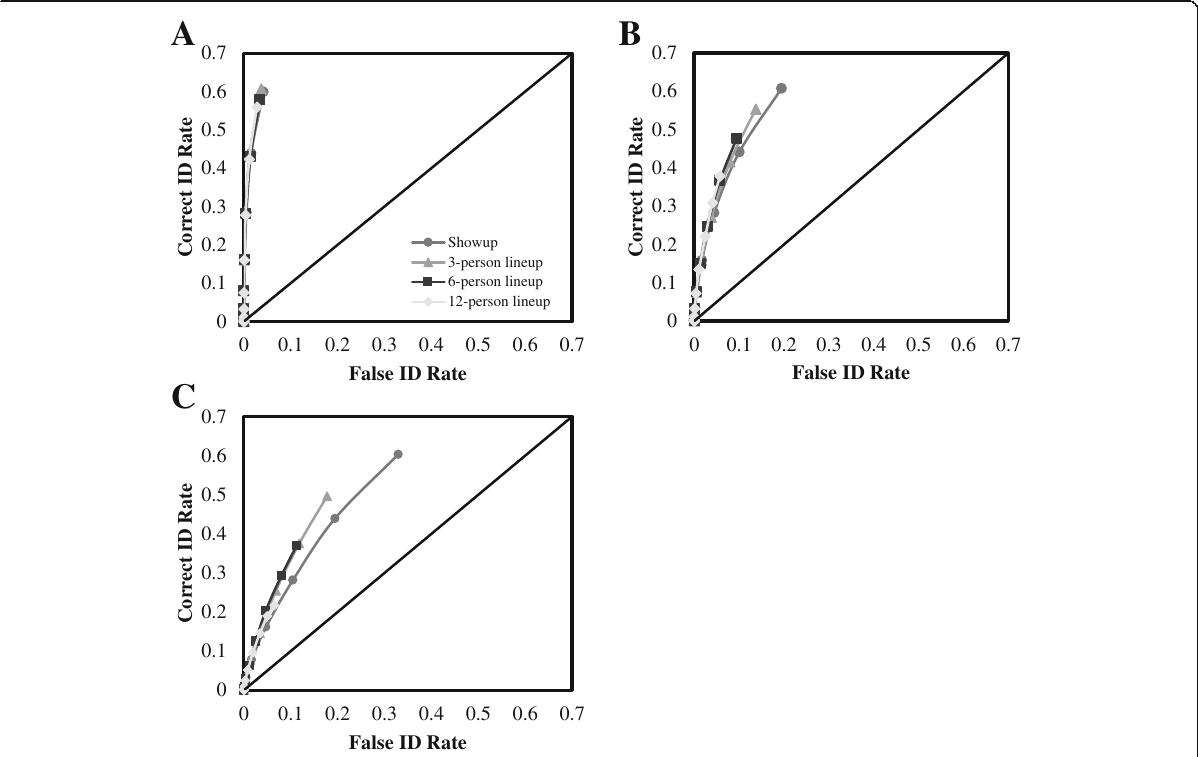
Fig. 1 Receiver operating characteristic (ROC) curves comparing showups, 3-, 6-, and 12-person fair lineups in which SSP = SSF . a SSP = SSF = .3, b SSP = SSF = .6, c SSP = SSF = .75. Encoding fixed at a = .3, and csim = csu = .09. The solid diagonal line indicates chance performance (guilty and innocent suspects chosen at the same rates). SSP Similarity of the innocent Suspect to the PERP (perpetrator), SSF Similarity of the Suspect to the